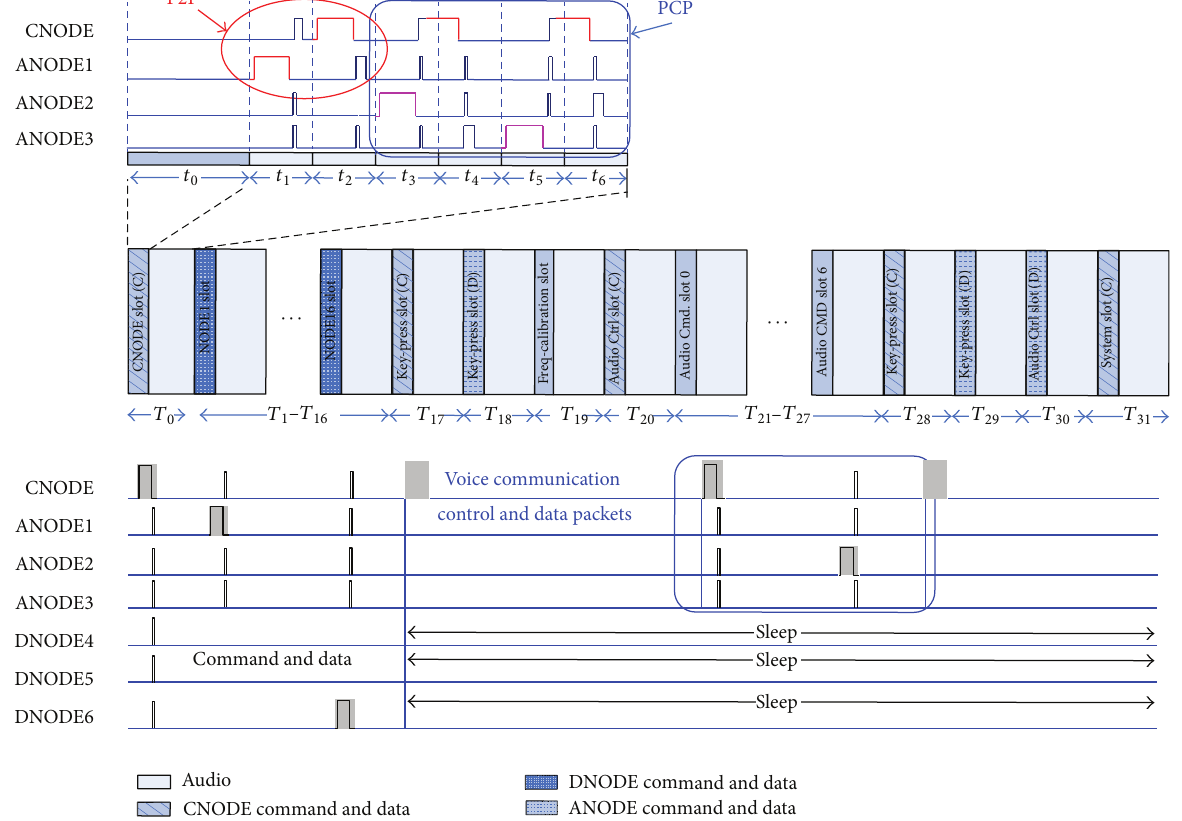
Figure 4: A-LNT channel allocation and address filtering